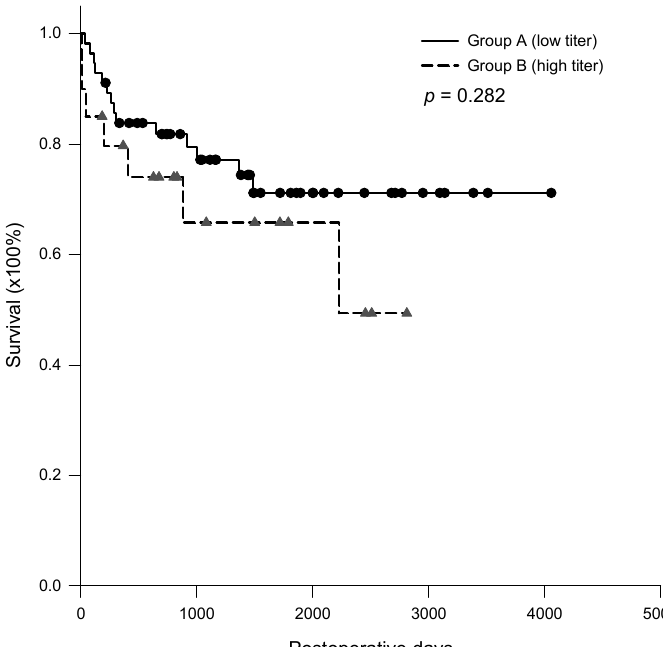
Figure 5. Kaplan–Meier survival curves for the patients in group A and B. The 6-month, 1-, 3- and 5-year graft and patient survival were 91.1%, 83.8%, 77.1%, and 71.1% for group A patients, and 85.0%, 79.7%, 65.8%, and 65.8% for group B patients, respectively ( p = 0.282).